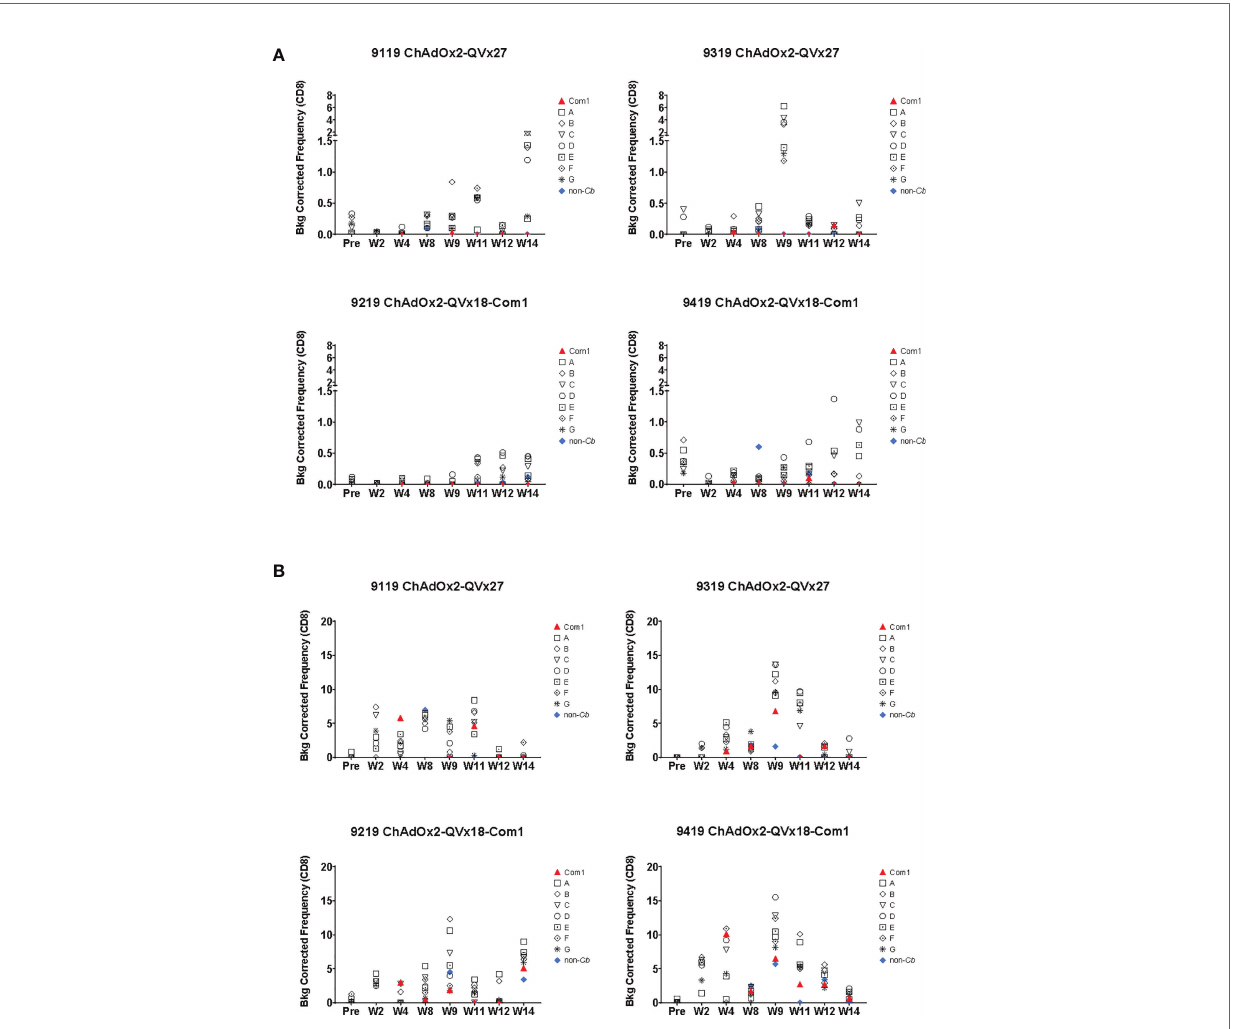
FIGURE 7 | Ex vivo CD8 + T cell recall responses to vaccine epitopes in vaccinated cynomolgus macaques. Study time points are indicated on the X axis (Pre = pre- vaccination; W = Week); see Figure 6A for the corresponding vaccination schedule. Individual macaque identi fi cation numbers and prime vaccine are noted in each graph title. MVA-kQVx27 boost vaccinations were administered at Week 8 and Week 11. PBMCs from individual animals were stimulated ex vivo by indicated epitope peptide pools (A-G, see Methods), a pool of peptides representing the full Com1 protein sequence, a short concatemer of non- Coxiella peptide sequences (non- Cb ), or no peptide. T cell activation status following peptide stimulation was evaluated by fl ow cytometry. The frequencies of (A) CD8 + IFN g + or (B) CD8 + T-bet + T cells are shown as a percentage of total CD8 + T cells (Y axis). Data shown are background corrected (peptide